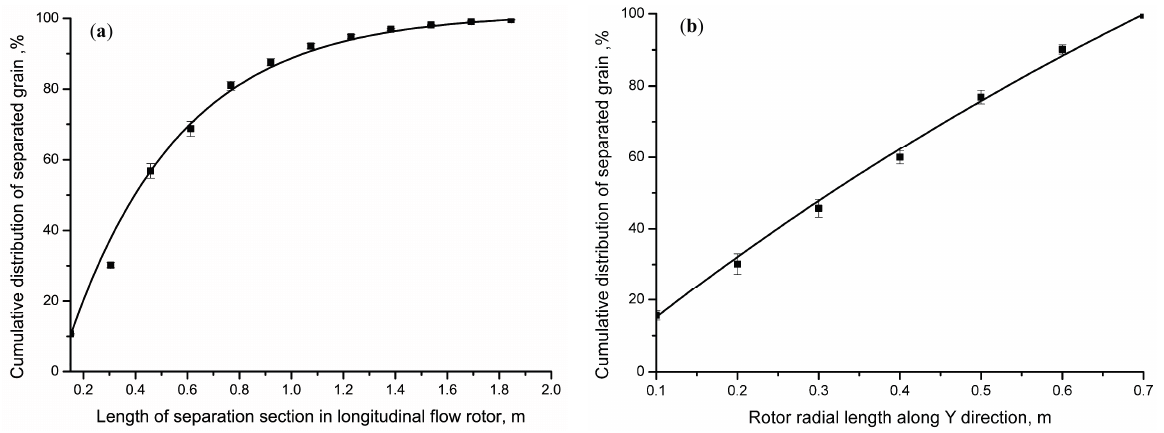
Figure 4. Cumulative distribution of separated grain in the X direction and Y